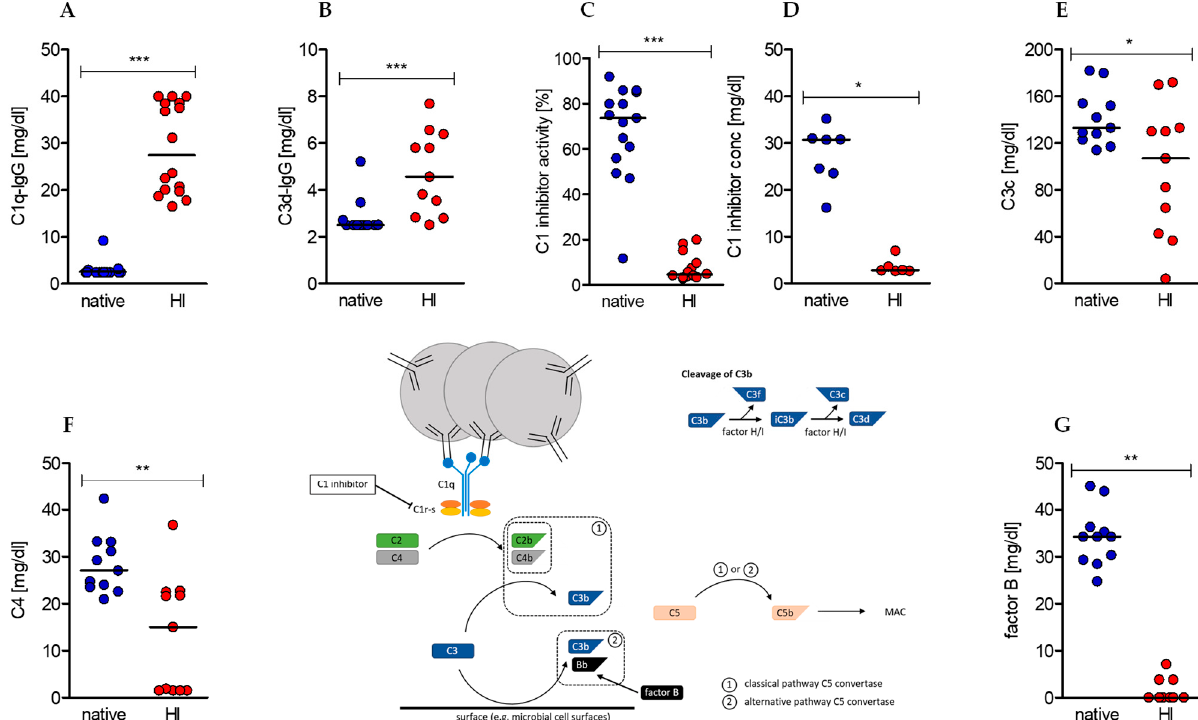
Figure 1. Effects of serum heat-inactivation on complement-bearing immune complexes, complement (co-)factors, and regulators. ( Center ) The depicted scheme represents the initiating steps and essential (co-)factors and regulators of the classical and alternative complement cascade as well as the cleavage pathway of complement factor C3. ( A – G ) Concentrations of complement-bearing immune complexes ( A ) C1q-IgG and ( B ) C3d-IgG. ( C ) The concentration and ( D ) activity of complement regulator C1 inhibitor as well as the concentration of complement (co-)factors ( E ) C3c, ( F ) C4, and ( G ) factor B were determined in native sera (blue dots) and after heat-inactivation (red dots). (median of (A) native n = 17, heat-inactivated (HI) n = 16; (B,E,F,G) n =11; (C) native n = 15, HI n = 14; (D) native n = 8, HI n = 7; Wilcoxon test; * p < 0.05, ** p < 0.01, *** p < 0.001).